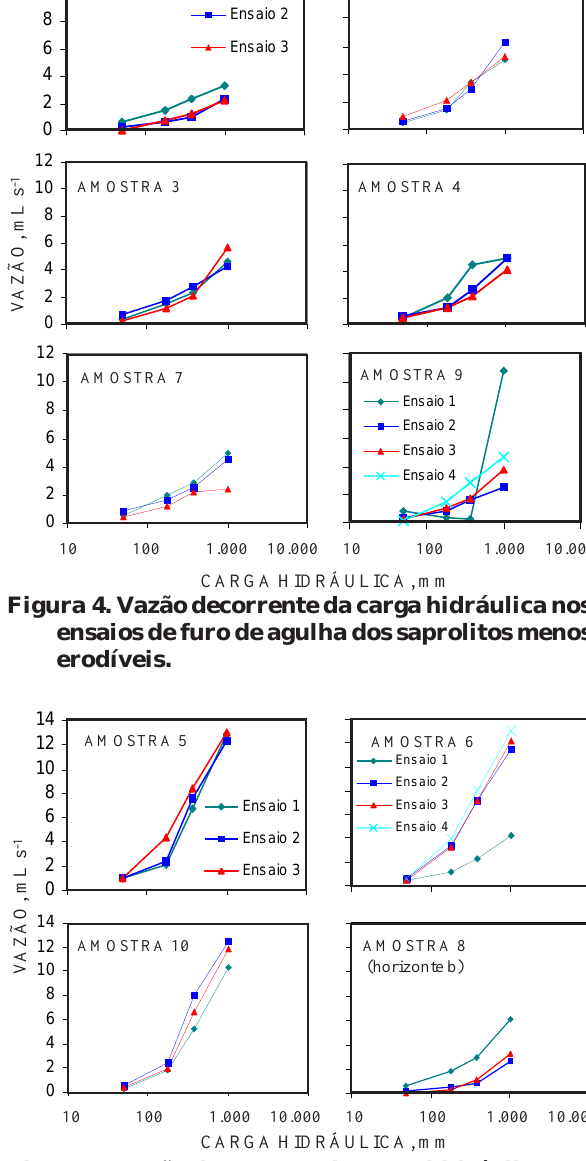
Figura 5. Vazão decorrente da carga hidráulica nos ensaios de furo de agulha dos saprolitos mais erodíveis e do horizonte